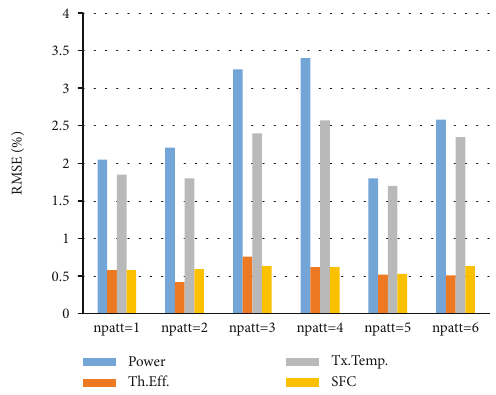
Figure 13: The RMSE for comparison of predicted and experimental performance data.